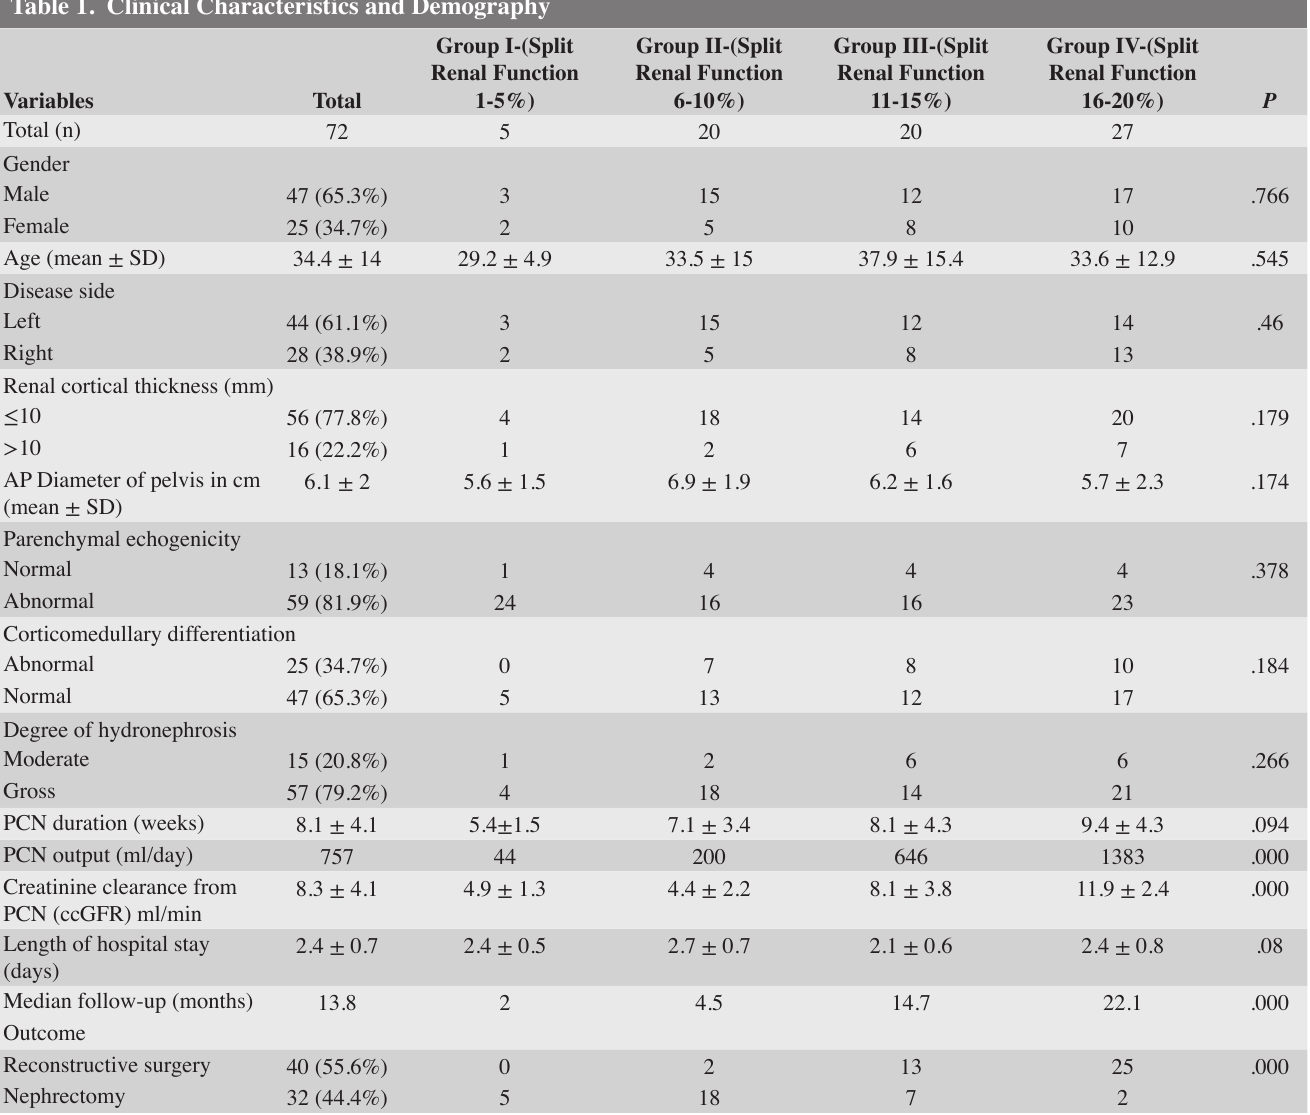
Table 1. Clinical Characteristics and Demography